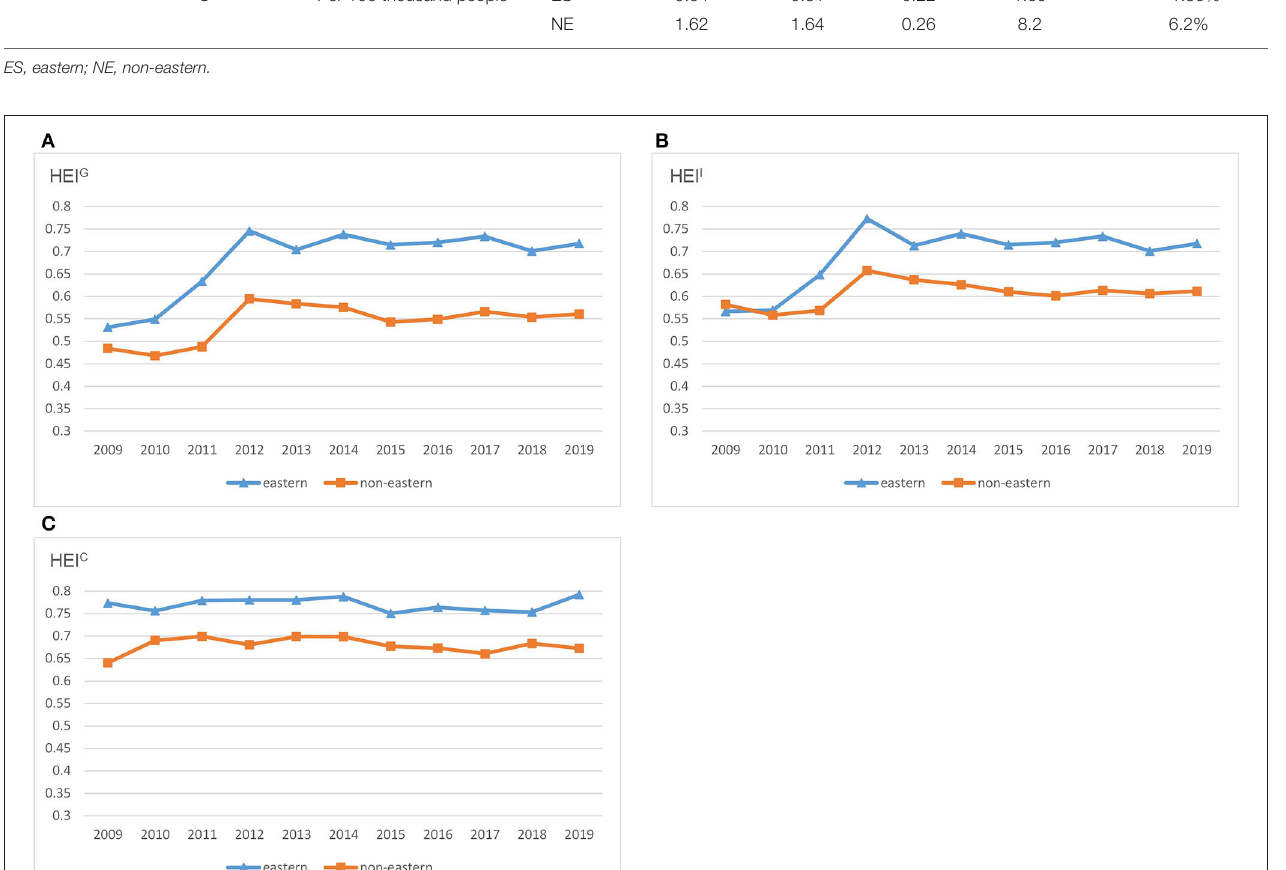
eastern region show similar time trend to that in non-eastern 2011 to 2012 and reaches the maximum in 2012